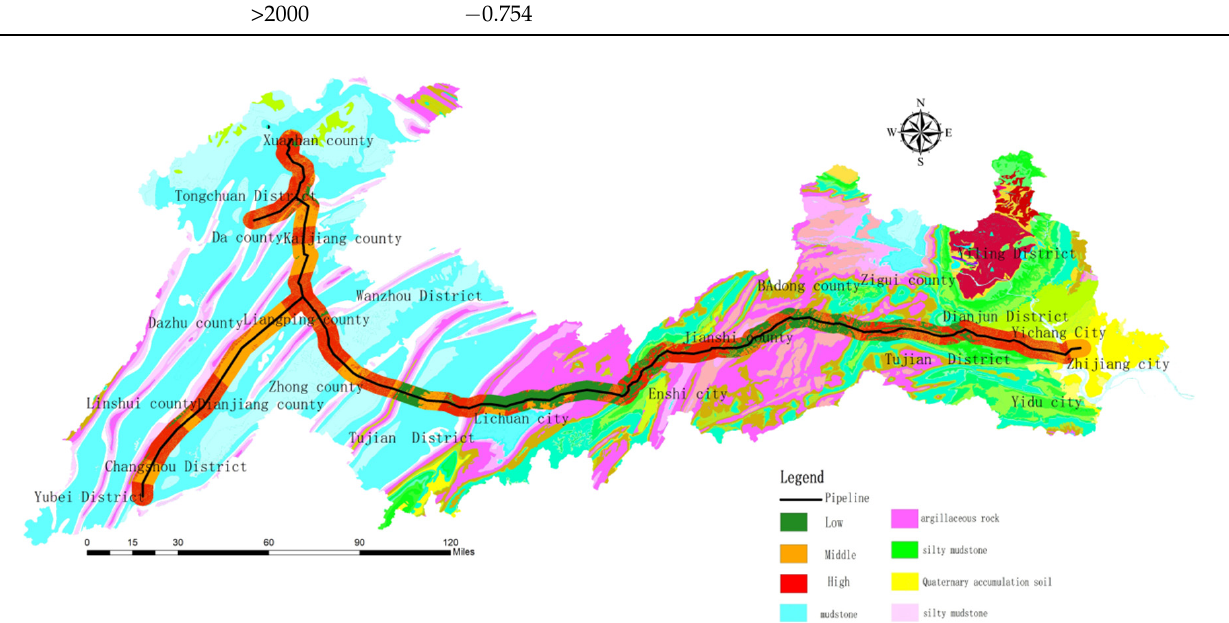
Figure 12. Hazard zoning map.